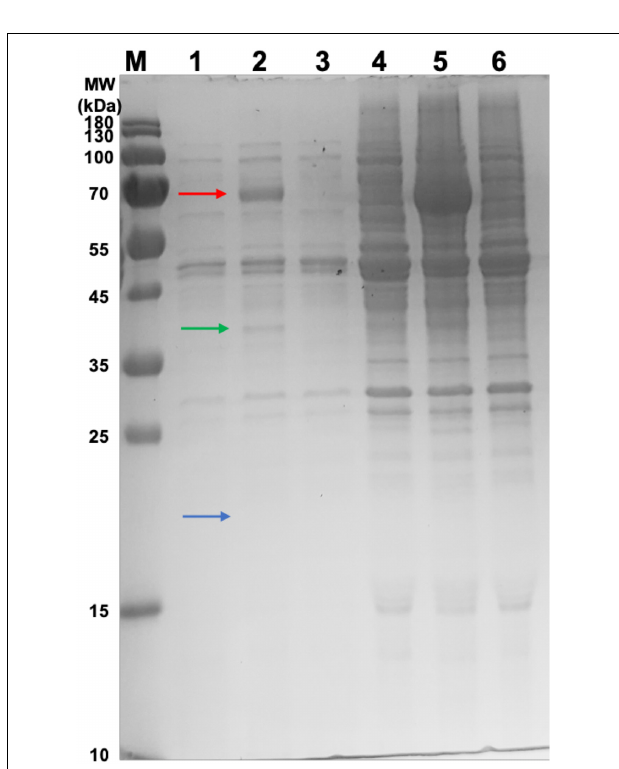
FIGURE 2 | SDS-PAGE gel of samples from the concentration of CFPS products after incubation in the assembly reaction mixture and associated flowthrough. Lane M: PageRuler pre-stained protein ladder. Lane 1, CFPS HBc retentate; Lane 2, CFPS HBc (+CIP) retentate; Lane 3, CFPS NC (no HBc template) retentate; Lane 4, CFPS HBc flowthrough; Lane 5, CFPS HBc (+CIP) flowthrough; Lane 6, CFPS NC (no HBc template) flowthrough. Red arrow indicates CIP ( ∼ 70 kDa). Green arrow indicates HBc dimer ( ∼ 40 kDa). Blue arrow indicates absence of band for HBc monomer (21